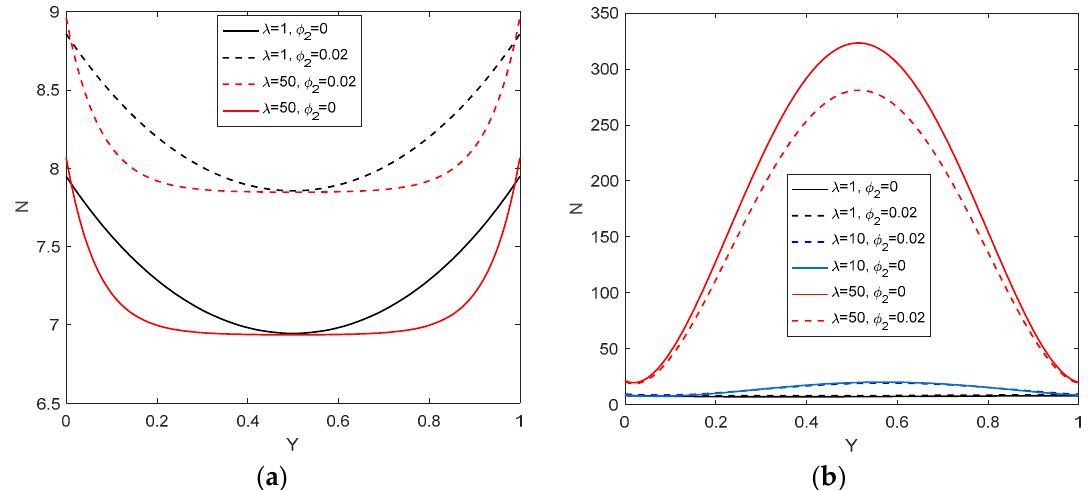
Figure 9. Entropy generation number for vertical channel ( a ) and for horizontal channel ( b ), for Pe = 1, depicted with a straight line for ϕ 1 = 0.1, ϕ 2 = 0.0 (regular nanofluid) and with a broken line for ϕ 1 = 0.1, ϕ 2 = 0.02 (hybrid nanofluid).